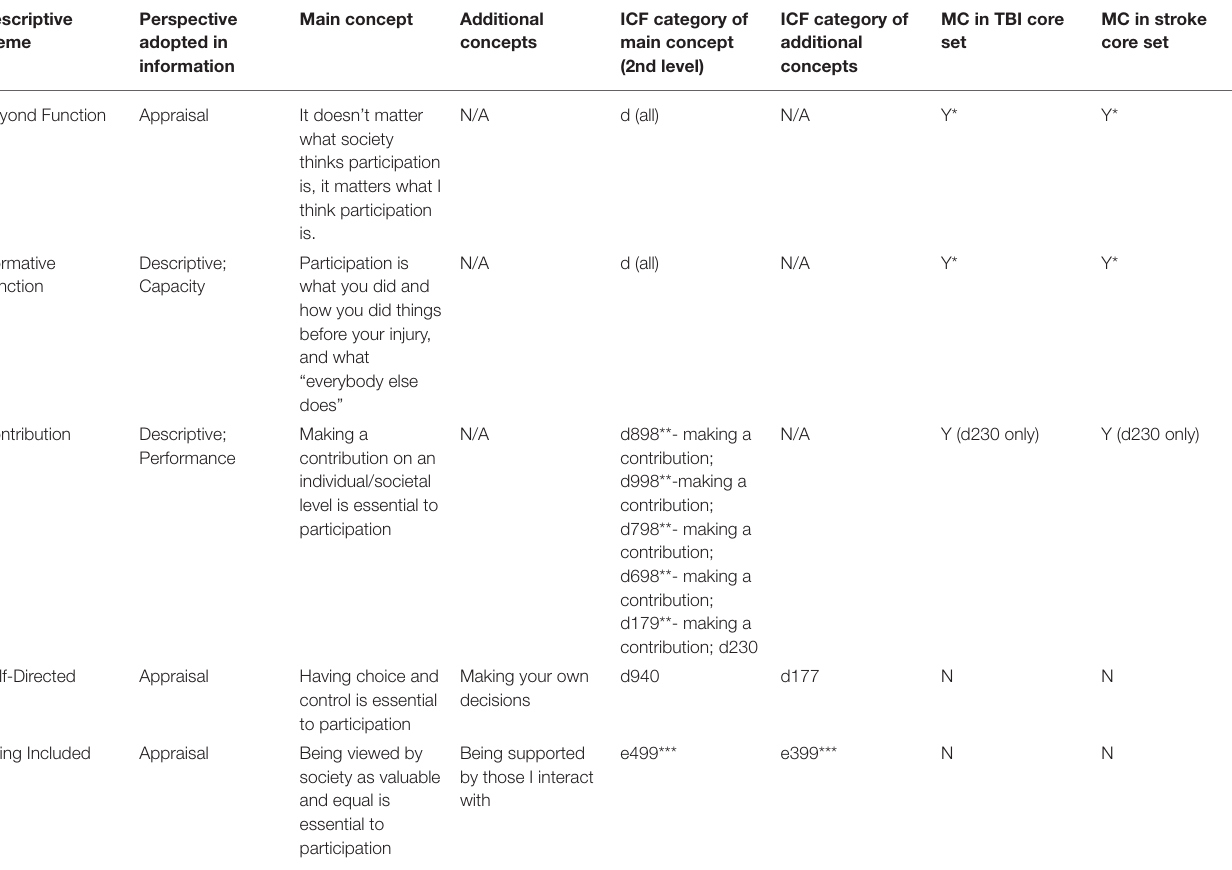
TABLE 5 | ICF linking to themes from essential elements of